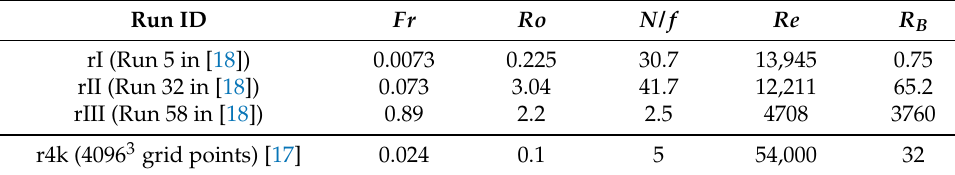
Table 1. Characteristics of the decay runs analyzed here: Froude and Rossby numbers, Fr , Ro and their ratio Ro / Fr = N / f , as well as Reynolds and buoyancy Reynolds numbers, Re , R B (see text for definitions, and see [18–20] for more data on the runs). The last line refers to a run on a grid of 4096 3 points analyzed in [17], run r4k. Like run rII, it belongs to the intermediate (second) regime of parameters as defined in [18] for rotating stratified turbulence. The four runs have isotropic random initial conditions centered in the large scales, with zero initial potential